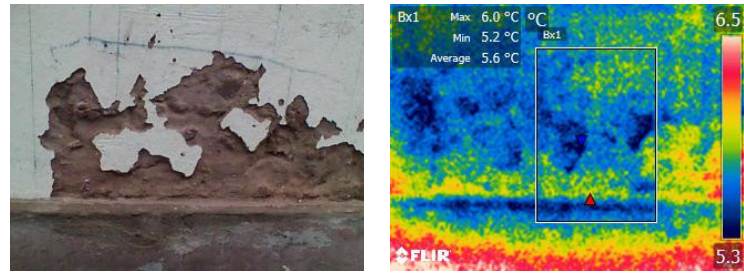
Figure 17. Analysis of facade damage.